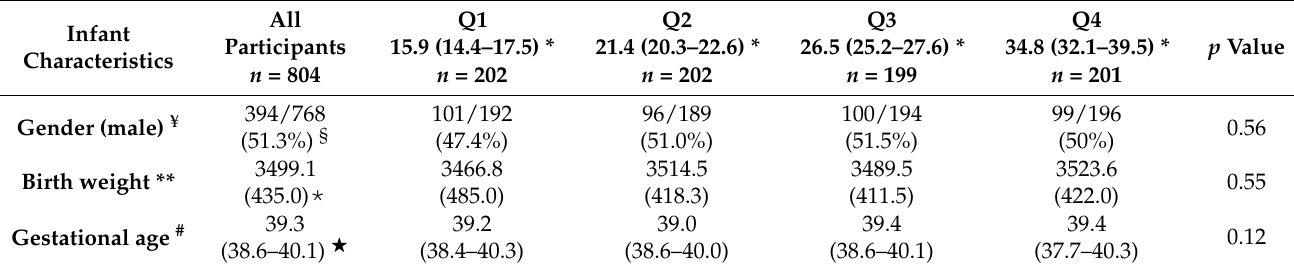
Table 3. Infant birth outcomes for the four quartiles of maternal dietary fiber intake.